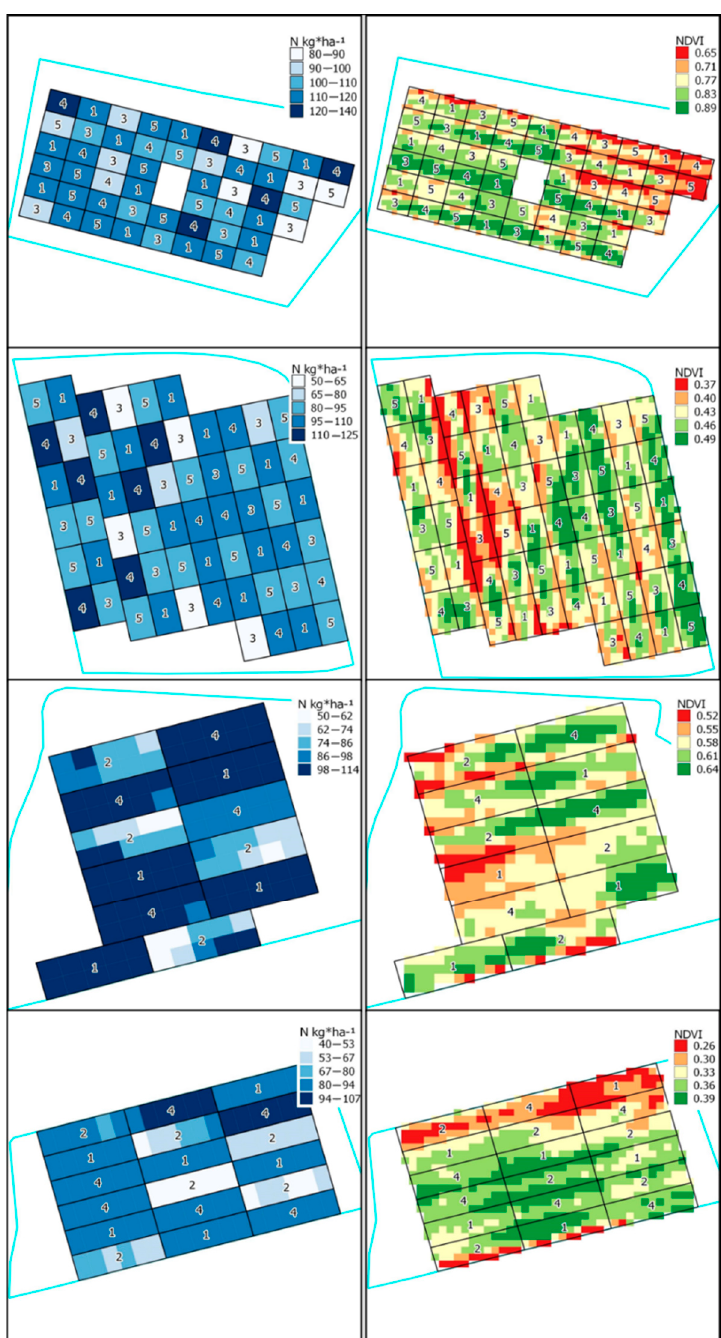
Figure 3. Prescription maps ( left ) and NDVI calculated before the second fertilization ( right ) maps for Fia19, Fia20, Sod19, and Sod20 ( top to bottom ). The numbers on the plots indicate the different experimental treatments: Flat-N ( 1 ); Var-N-Inv ( 2 ); Var-N-Dir ( 3 ); Var-N-Agrosat ( 4 ); and Var-N- Agricolus ( 5 ). The fields’ outer borders are plotted in